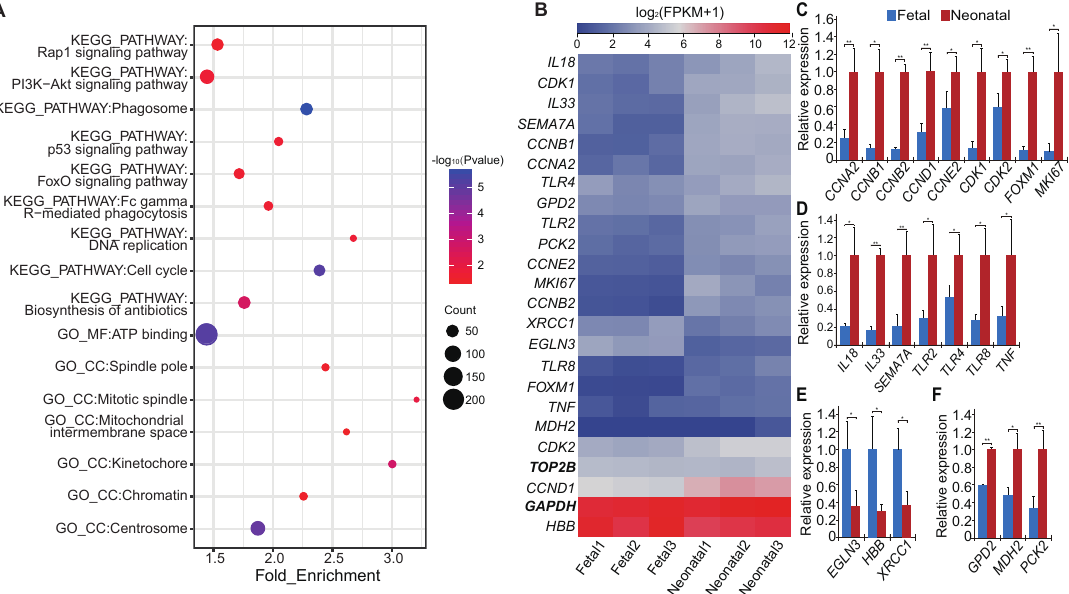
Figure 2. Differentially expressed (DE) mRNAs revealed the changes in the lung after birth. ( A ) Mainly enriched categories for differentially expressed genes. The function enrichment analysis of the DE genes was performed using DAVID and the listed terms were with Benjamini corrected p value < 0.05; we set 3248 DE genes as gene list and all expressed genes (14,579 mRNAs) as background. ( B ) Heat map of 22 selected DE genes ( GAPDH * and TOP2B * were used as internal control genes). Quantitative Real Time-Polymerase Chain Reaction (qRT-PCR) expression verification of crucial genes in the following related categories: ( C ) cell proliferation, ( D ) immune response, ( E ) hypoxia response, ( F ) and mitochondrial activation. * p value < 0.05, ** p value <